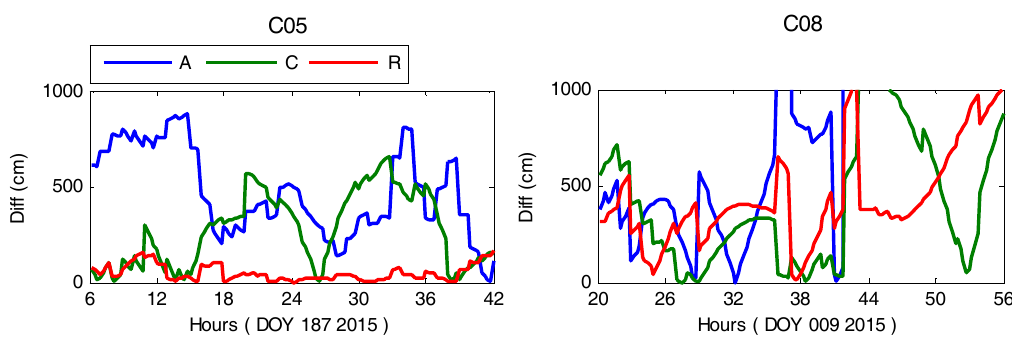
Figure 12. Accuracy of the broadcast ephemeris after the orbit maneuver. WHU product is used to evaluate the orbit accuracy.